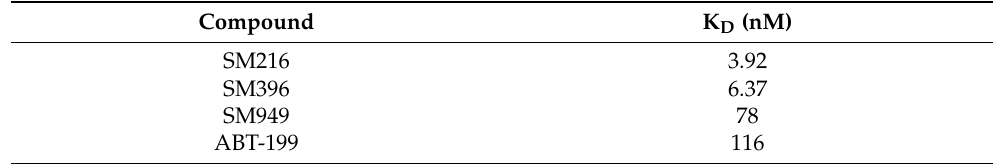
Table 2. Binding affinities of SM216, SM396, SM949, and ABT-199 for BCL-2 (surface plasmon resonance).